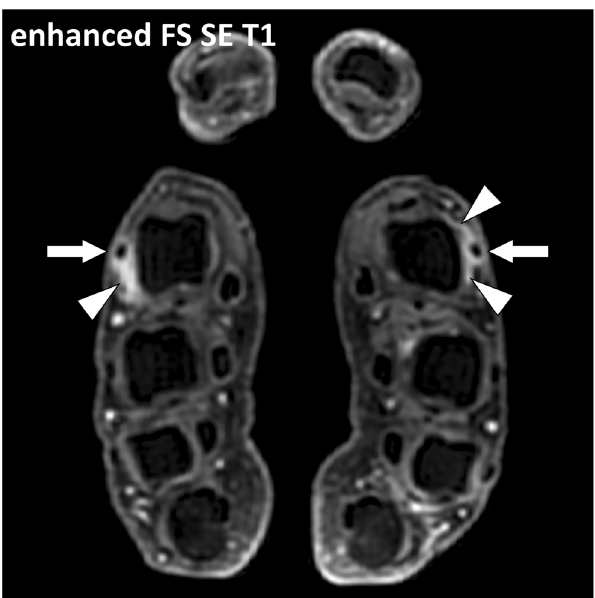
Fig. 14 Contrast-enhanced fat-suppressed T1-weighted axial image of the hands of a 29-year-old female with seropositive rheumatoid arthritis. Peritendinitis of the extensor digitorum tendons of the second digits (arrows) is associated with thickening and enhancement of the connective tissue around the tendons and the dorsal parts of the sagittal bands (ar- rowheads). The term B peritendinitis ^ seems more appropriate than B tenosynovitis ^ as there is no synovial sheath around the extensor ten- dons at the level of the metacarpophalangeal joints